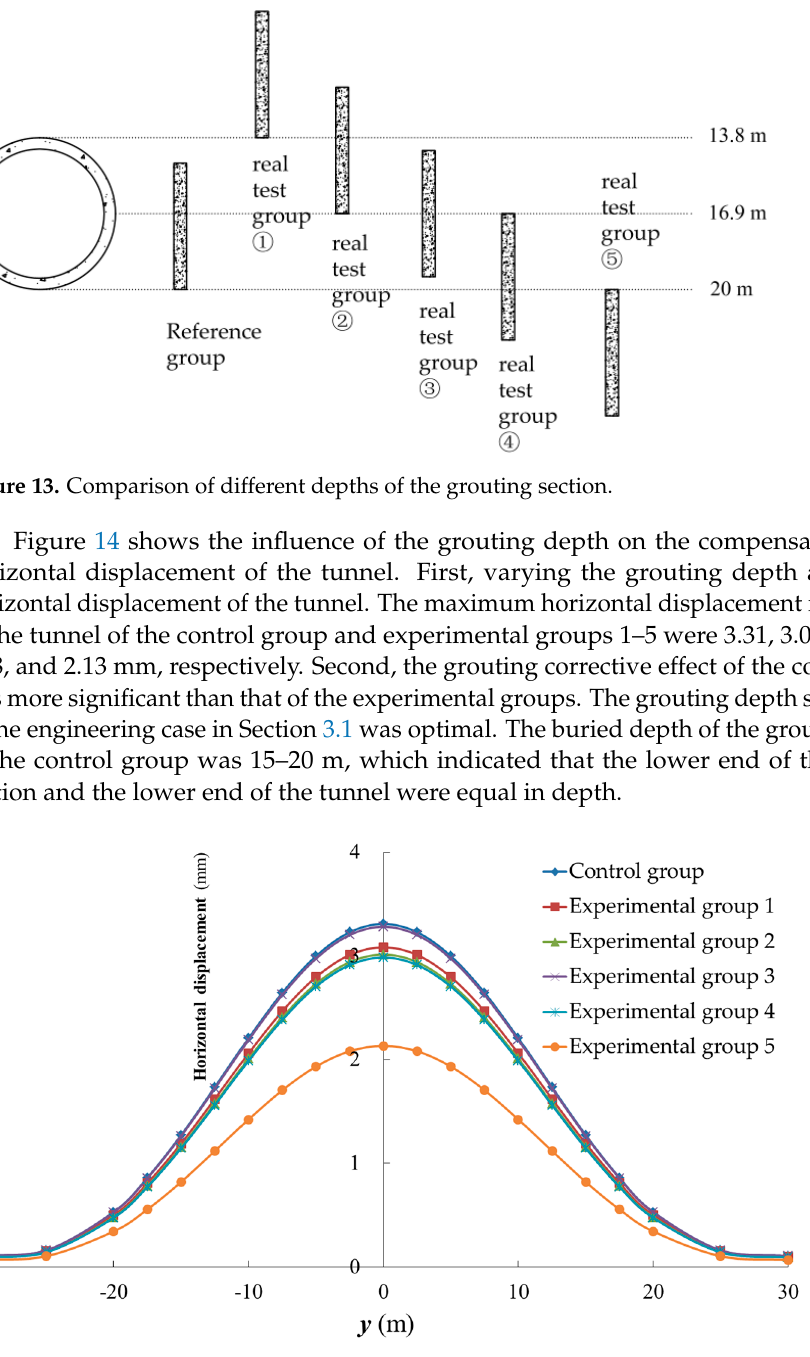
Figure 14. The influence of the grouting depth on the compensated level of horizontal displacement of the tunnel.